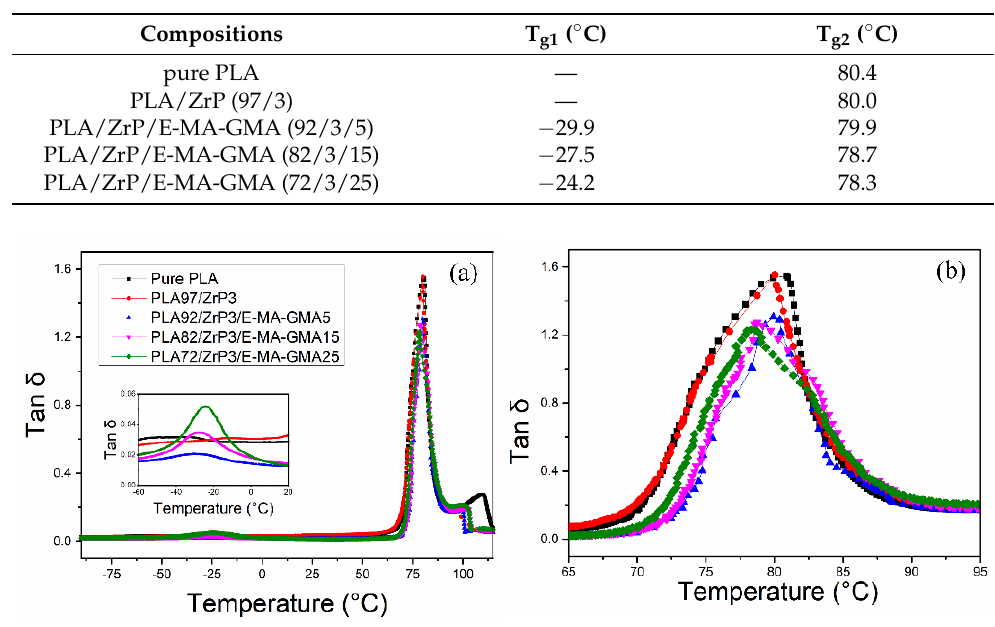
Figure 5. Tan δ curves of pure PLA, PLA/ZrP, and PLA/ZrP/E-MA-GMA nanocomposites in the ranges of ( a ) −9 0 °C to 115 °C and ( b ) 65 °C to 95 °C.